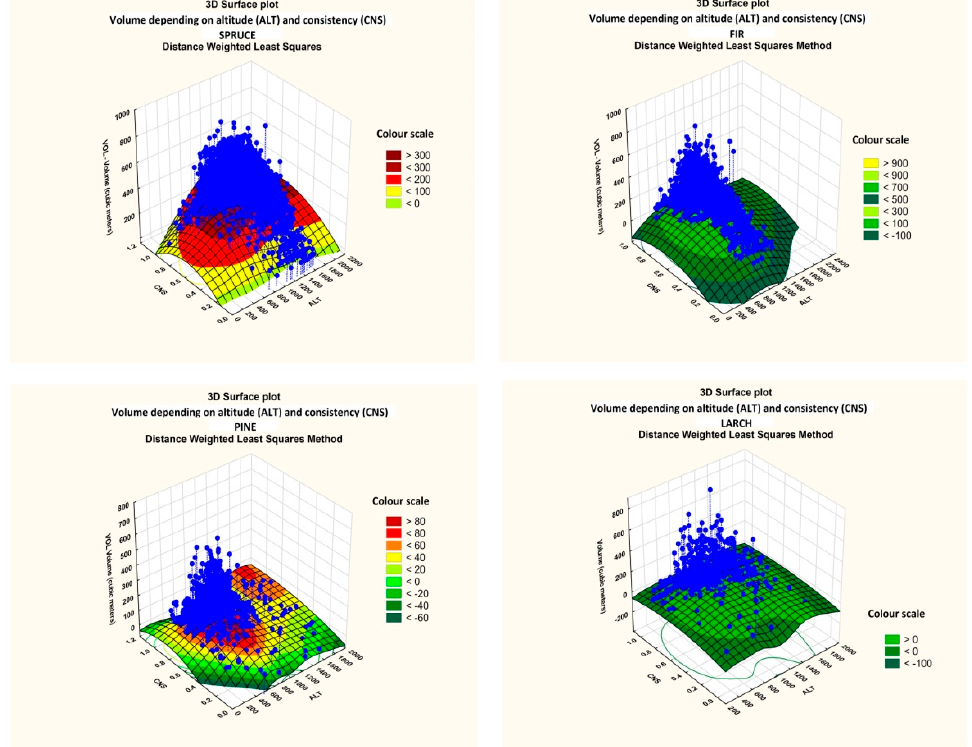
Figure 18. Three-dimensional VOL diagram based on ALT and CNS.